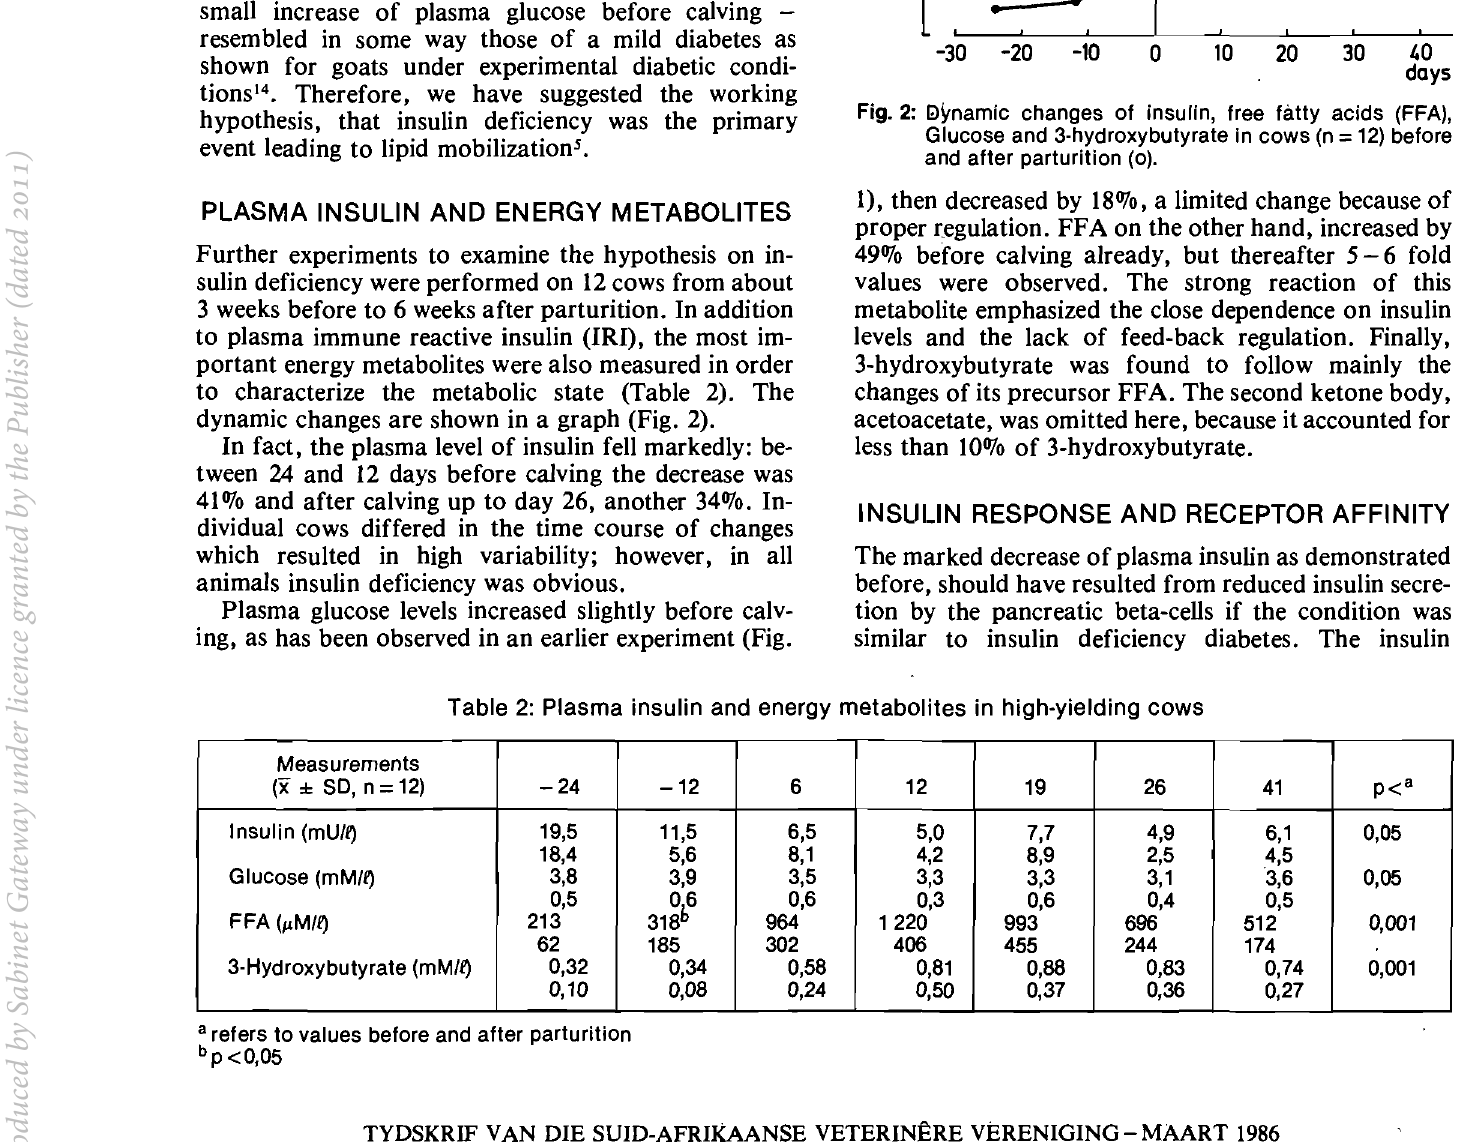
TYDSKRIF VAN DIE SUID-AFRlKAANSE VETERIN~RE VERENIGING - MAART